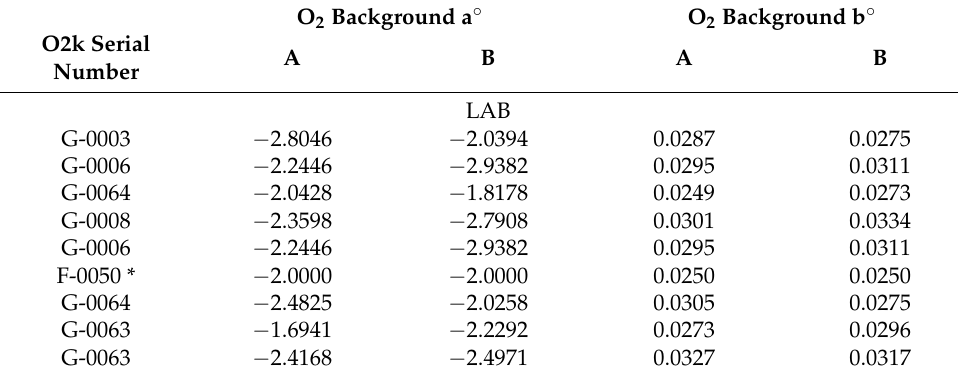
Table A1. O2k background O 2 flux in LAB and ultramarathon experiments. Values are shown in